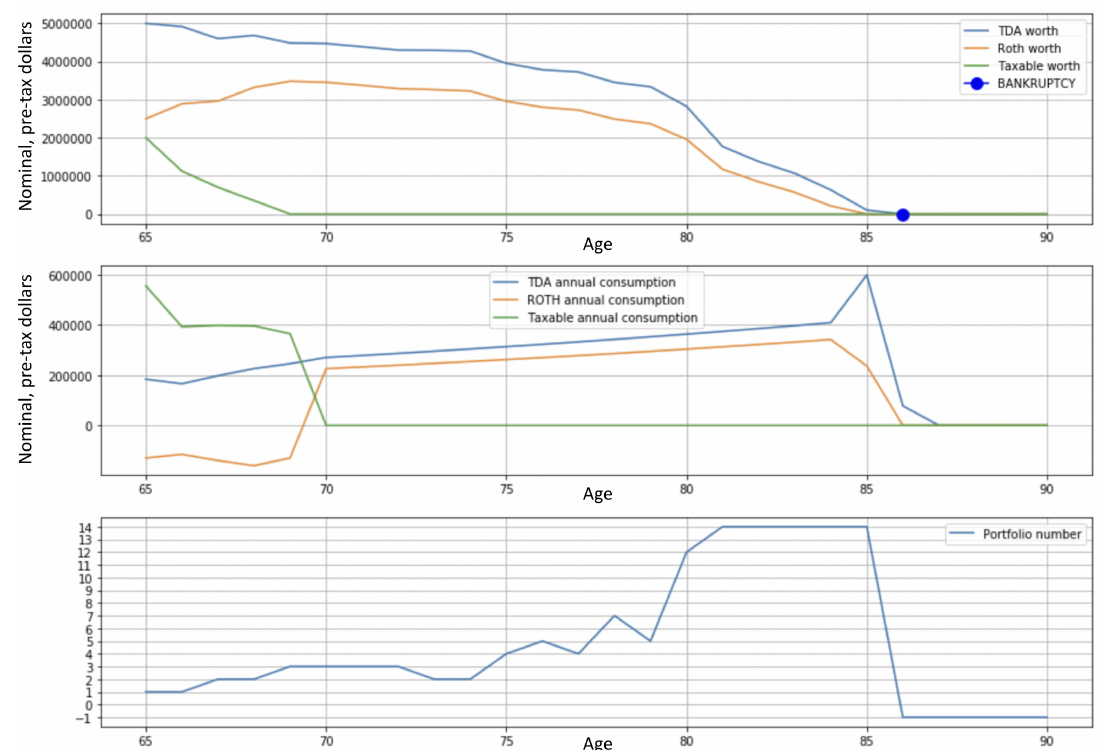
Figure 4. An example path for Investor #3 under the optimal strategy. In this case, instead of using mortality tables, it has been assumed that the investor’s date of death is projected to be at age 90. For this example path, the investor becomes bankrupt at age 86. As in Figure 3, age is on the horizontal axis, and in the top two panels, the dollar values on the vertical axes are in nominal, pre-tax dollars.